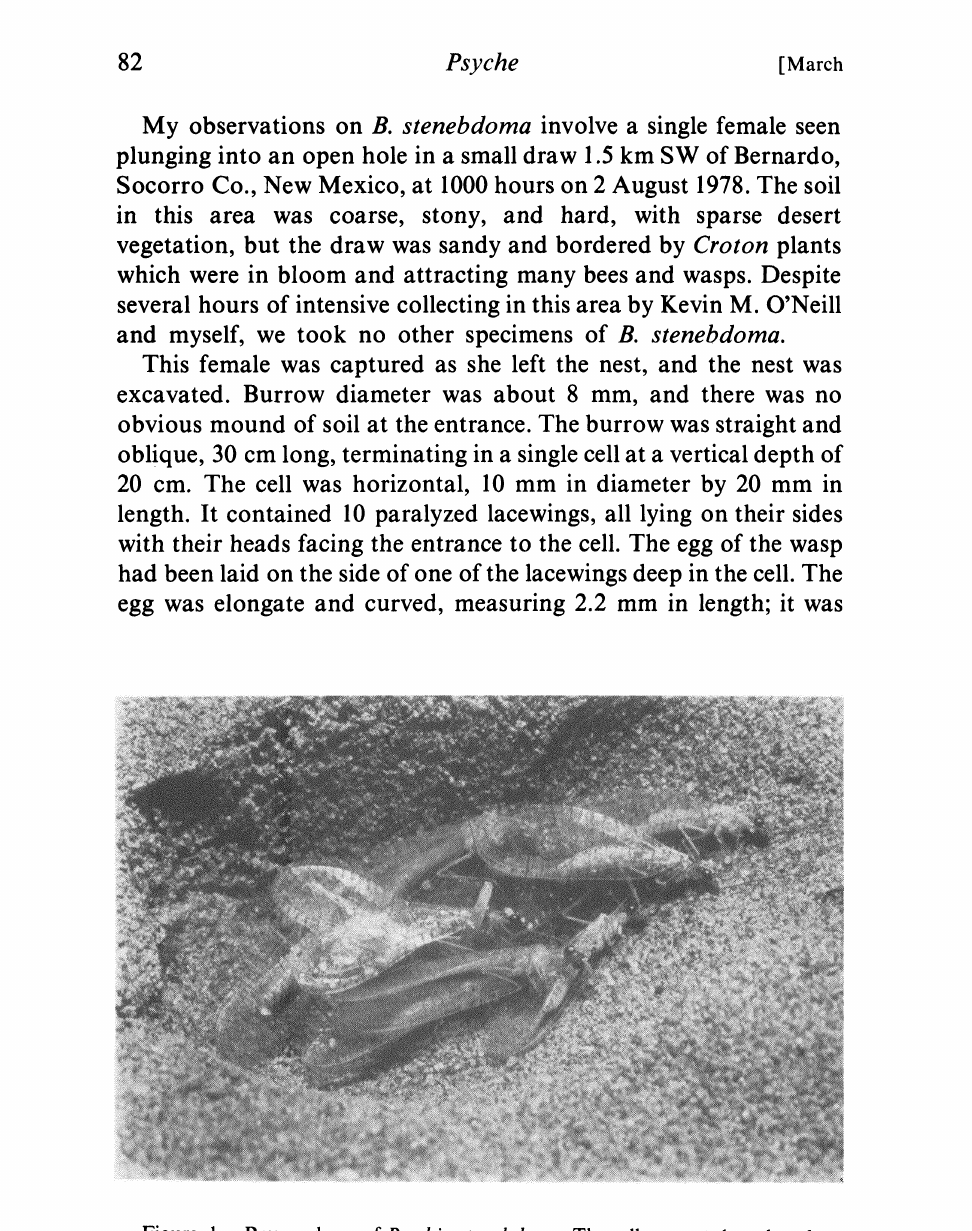
Figure 1. Prey and egg of Bembix stenebdoma. The cell contents have here been removed to an artificial cell and the lacewing bearing the egg moved to the top of the pile for purposes of